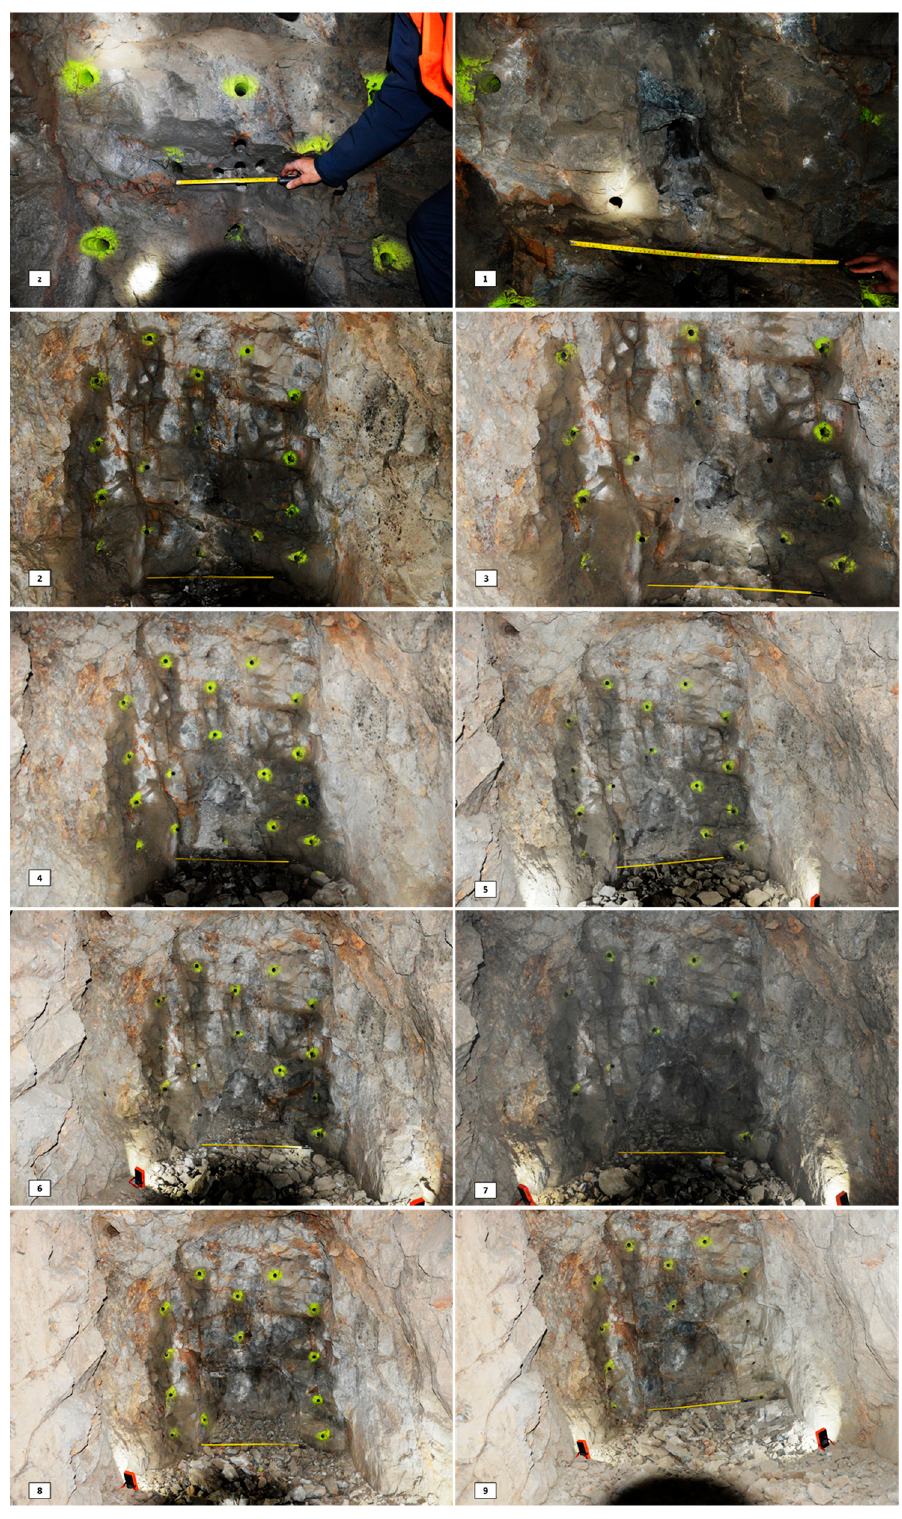
Figure 2. Evolution of the opening cut cavity. Numbers indicate the sequence number of the last hole that was detonated. The first picture shows the result of the first hole, where the rock was fragmented but not ejected. Ejection of the rock broken by the first hole happened at the detonation of the second hole.